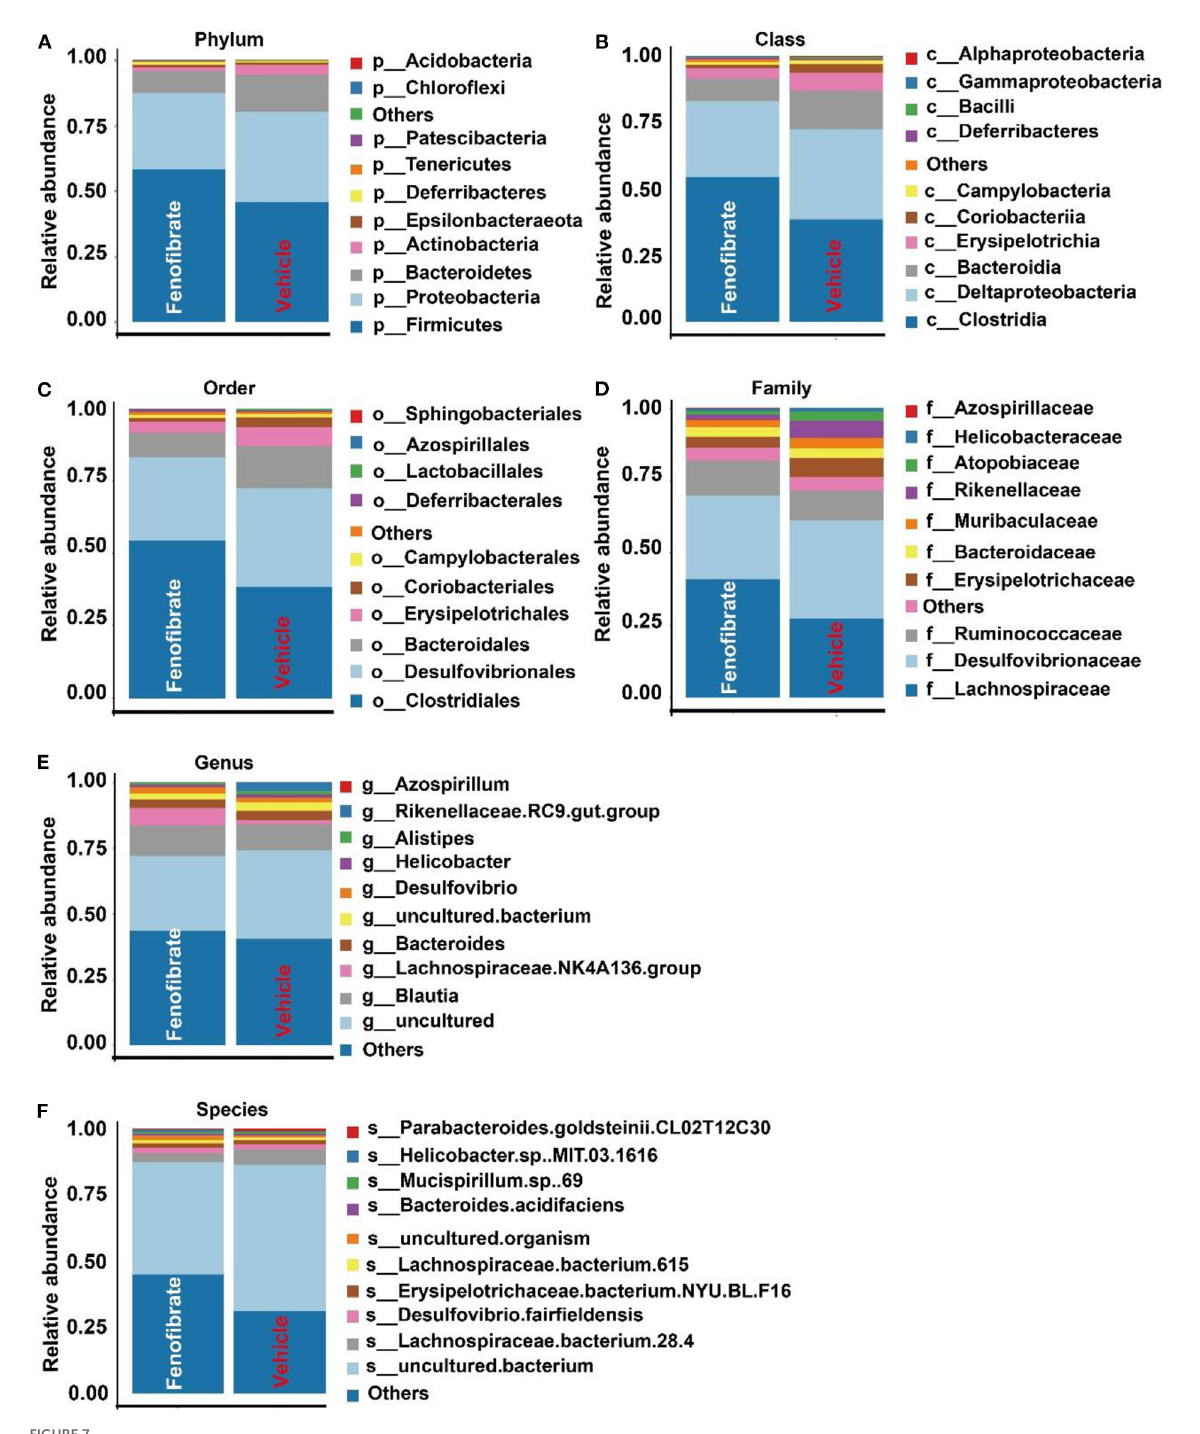
FIGURE7 Effect of fenofibrate on the gut microbiota species in different classification levels. The top 10 microbiota species in phylum (A) , class (B) , order (C) , family (D) , genus (E) , and species (F) levels. Vehicle: ob/ob mice were treated with 0.5mL of water by gavage for 13 weeks ( n = 7); Fenofibrate: ob/ob mice were treated with 0.5mL of fenofibrate suspension liquid at the dose of 20 mg/kg/d by gavage for 13 weeks ( n =